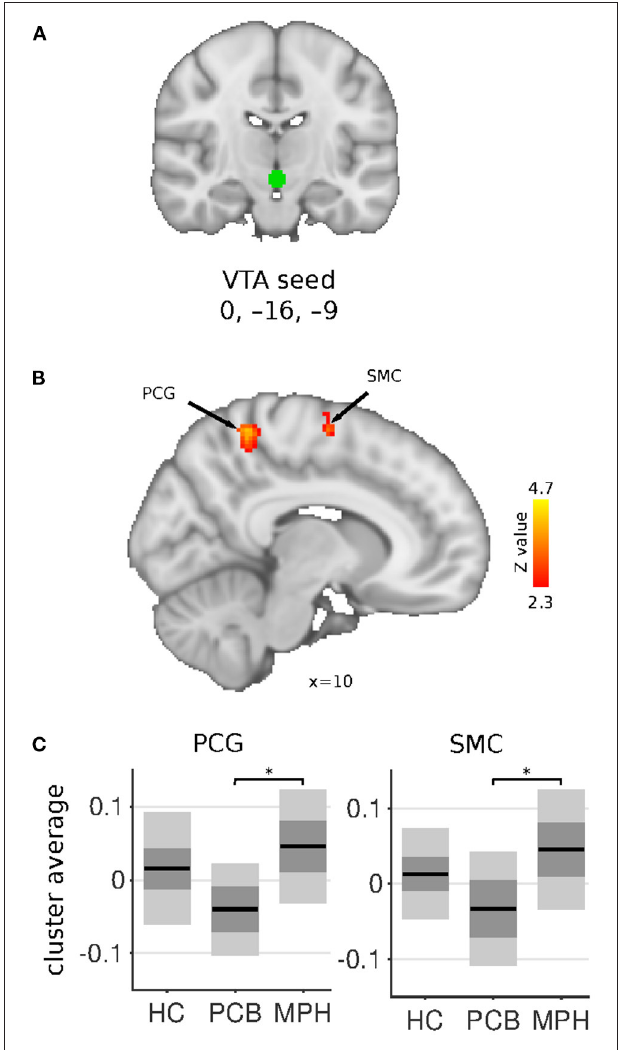
FIGURE 3 | VTA connectivity differences between HC, DBD-PCB, and DBD-MPH groups. (A) Location of the VTA seed. (B) Clusters showing significant connectivity differences ( Z > 2.3, cluster p < 0.05). (C) Average Fisher-Z transformed VTA connectivity in the significant clusters. Dark gray patches represent the 95% confidence interval and light gray patches represent the standard deviations. Lines represent the group means. All shown coordinates are in MNI space. VTA, ventral tegmental area; PCG, post-central gyrus; SMC, supplementary motor cortex; HC, healthy controls; PCB, placebo; MPH, methylphenidate; *cluster- p <